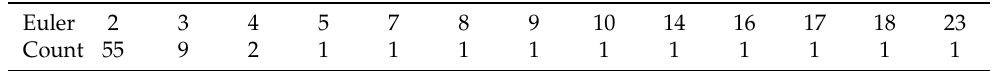
Table 4. Second decomposition type—distribution of combinatorial Euler characteristics of Tetrahe- dron3DNet objects from interior overlay.